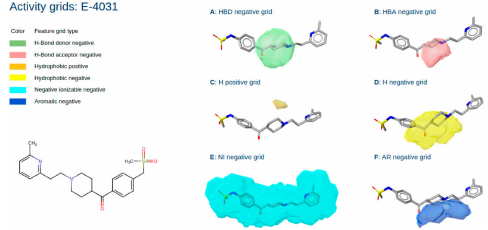
Figure 4. Structure of the known hERG blocker E-4031 and its respective activity grids: hydrogen bond donor negative grid (A); hydrogen bond acceptor negative grid (B); hydrophobic positive grid (C); hydrophobic negative grid (D); negative ionizable grid (E); aromatic negative grid